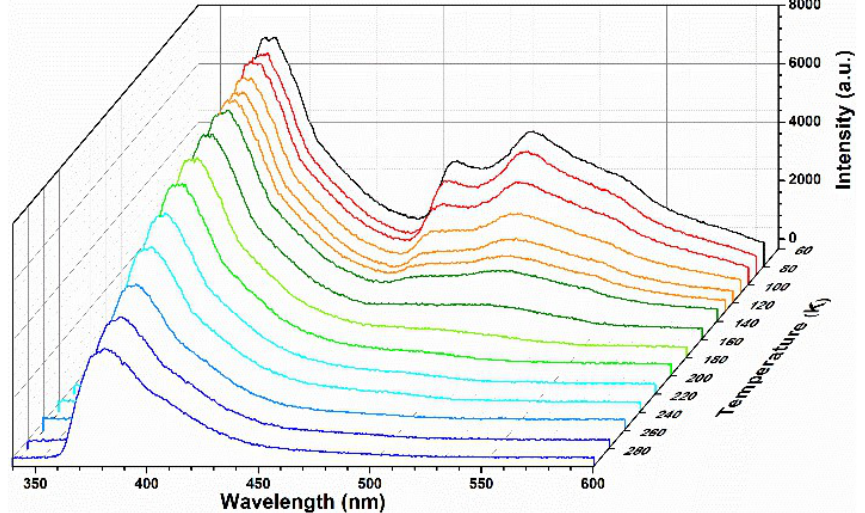
Figure 3. Temperature-dependent emission spectra of SNNU-63 in the range of 80–300 K.